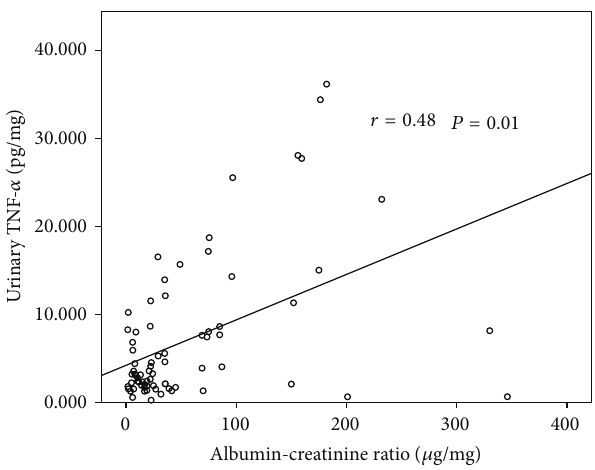
Figure 1: Correlation between ACR and urinary TNF- 𝛼 in patients with diabetes mellitus type 2.